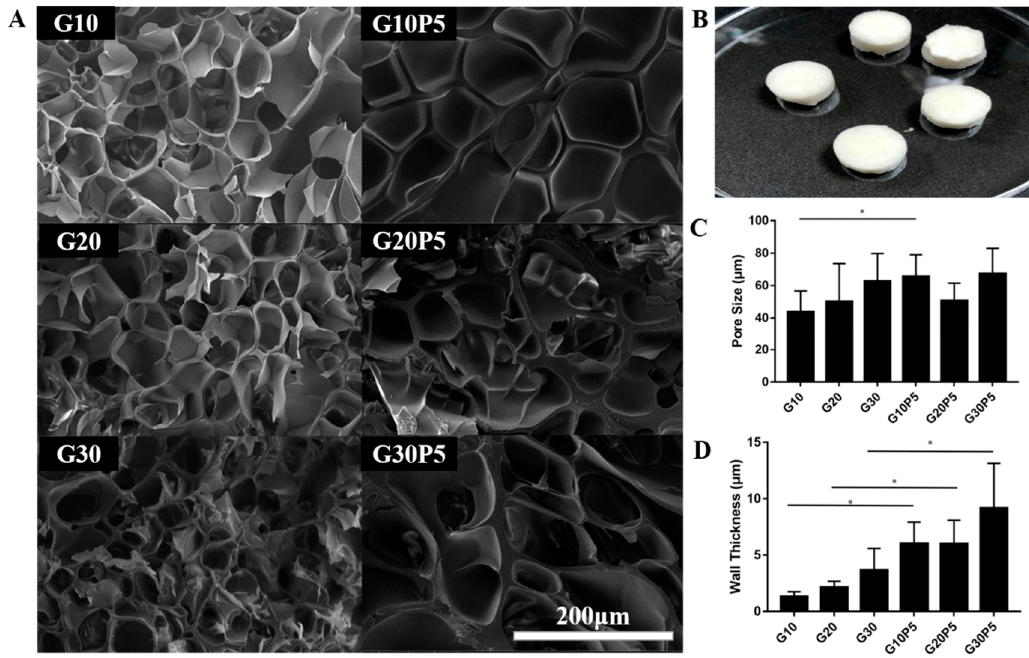
Figure 2. ( A ) SEM images of cross-section of GelMA hydrogel and GelMA/PEGDA hydrogel; ( B ) the Hydrogel was Freeze-dried after fully swelling; ( C ) the average pore size counted by Image J based on SEM images; ( D ) the average wall thickness counted by Image J based on SEM images (* P < 0.05).